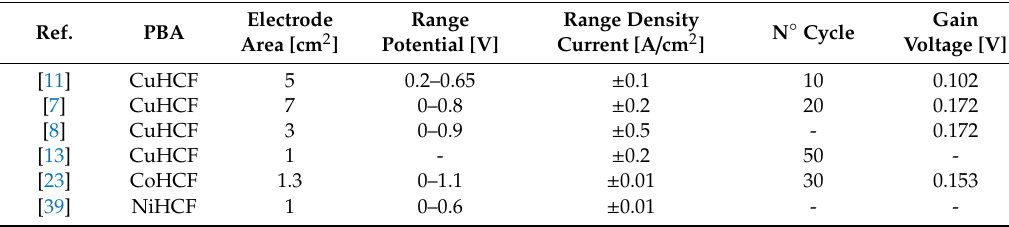
Figure4. SchematicstructureofCopperHexacyanoferrate(CuHCF)(ICSDno. 99499). Illustrationbased Figure 4. Schematic structure of Copper Hexacyanoferrate (CuHCF) (ICSD no. 99499). Illustration from [36,46]. based from [36,47]. Table 2. Prussia blue analogue material as cathode in